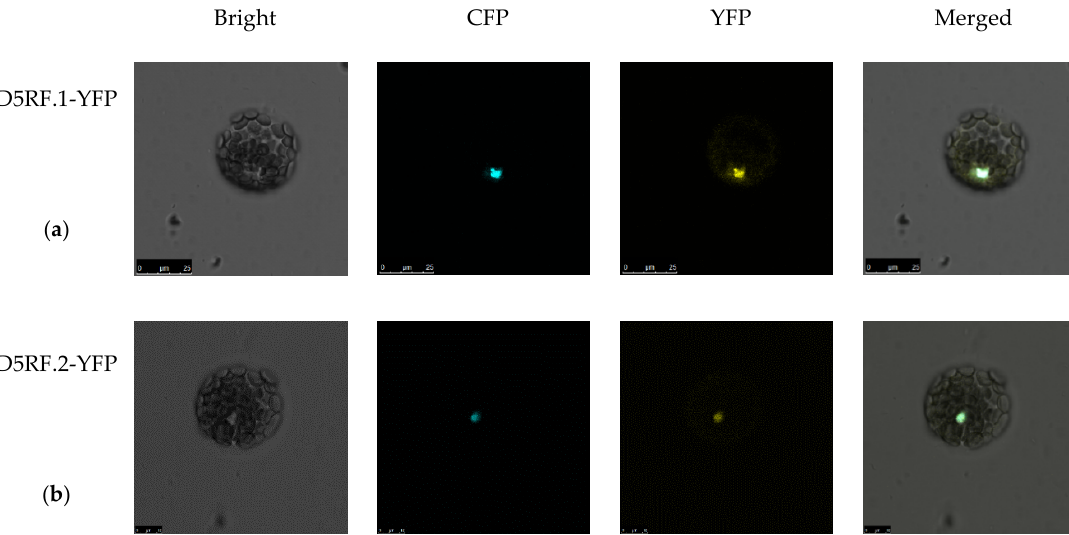
Figure 3. Subcellular localization assay for D5RF.1 and D5RF.2 proteins. The D5RF.1-YFP or D5RF.2- YFP vectors were separately co-transferred with the 35S::CFP-Ghd7 vector into Arabidopsis protoplast cells ( a , b ). The 35S::CFP-Ghd7 was used as the nucleic marker. The confocal image was observed using a confocal laser scanning microscope.